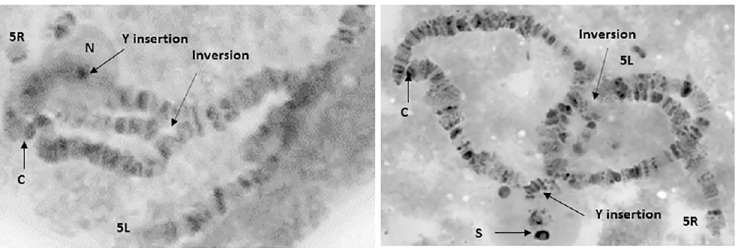
Fig 4. Polytene chromosomes derived from trichogen cells of 5 – 6 days old male pupae of the V8-118 line. The 5L and 5R chromosome arms are marked. The D53 inversion and the Y-autosomal translocation are indicated. N: nucleolus, C: centromere, S: dense sphere, representing the Y